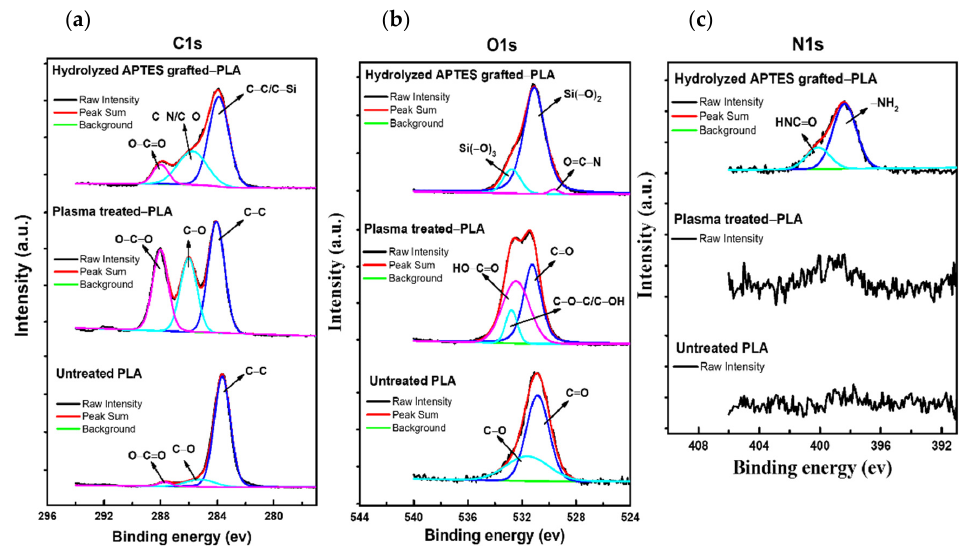
Figure 4. The comparison of the ESCA spectrum for each treatment includes: ( a ) C1s spectrum; ( b ) O1s spectrum; ( c ) N1s spectrum.